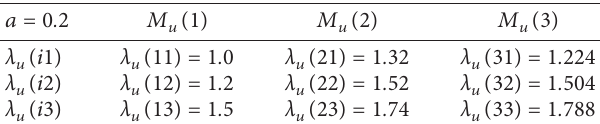
( i ) for a � 0 . 2, unit: u